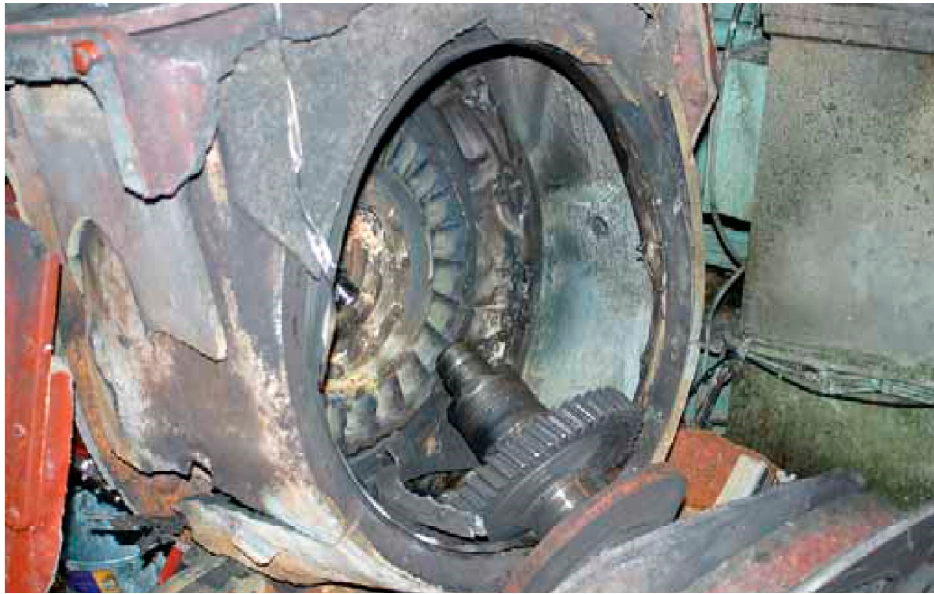
Figure 3. View of the turbocharger of the main engine of the ship m/v Goliath after the explosion on 12.02.2003 (Australian Transport Safety Bureau, 2006).